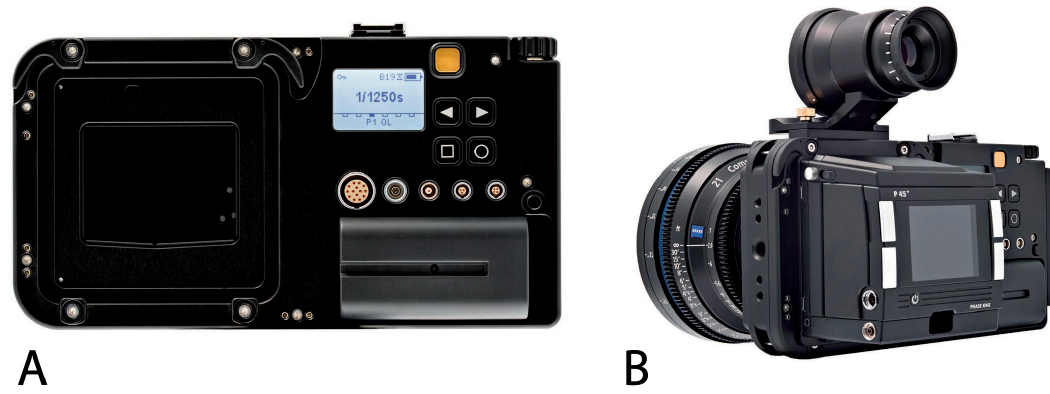
Figure 2. ( A ) The rear of the ALPA 12 FPS; and ( B ) The ALPA 12 FPS with a Zeiss Distagon T* CP 2 21 mm T/2.9 lens and a P45+ digital back of Phase One. All images courtesy of ALPA of Switzerland.